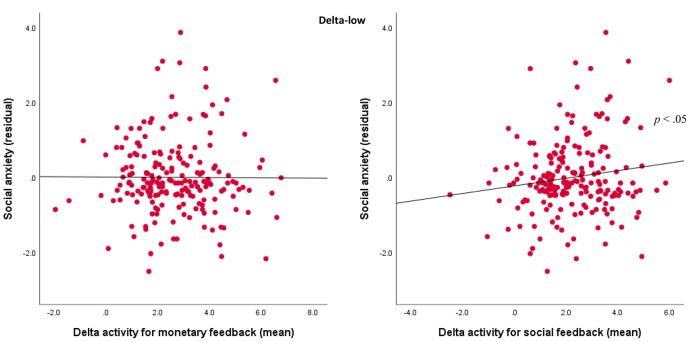
Associations between TF1SF1 (delta-low activity) for social and monetary feedback and symptoms. Scatterplots displaying the associations between social anxiety residuals with delta-low activity for mean monetary feedback averaged across both valence and outcome (left) and mean social feedback averaged across both valence and outcome (right).